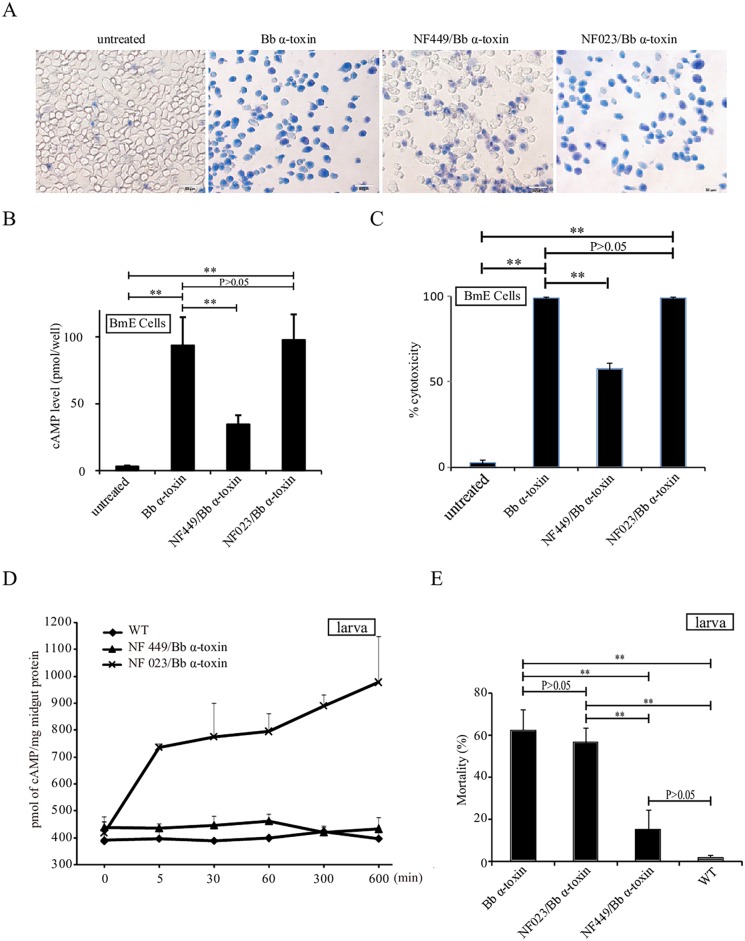
Involvement of Gαs in Bb α-toxin protein pathogenicity.(A) Trypan blue staining of nuclei of BmE cells pre-treated with NF449 (1μM) or NF023 (1μM) with Bb α-toxin-induced cytotoxicity. NF449-treated cells (NF449/Bb α-toxin) were protected from cytotoxic action of Bb α-toxin protein whereas NF023-treated cells (NF023/Bb α-toxin) were not. Blue color represents dead cells; live cells appeared colorless. (B) Effect of the inhibitors NF449 and NF023 at 1μM on cAMP production in cells. cAMP was measured in BmE cells after treatment with Bb α-toxin protein in the presence or absence of the indicated inhibitor. (C) Relative cytotoxicity (%) of Bb α-toxin protein in the presence of NF449 or NF023. (D) Assessment of cAMP levels in the presence of NF023 or NF449 under Bb α-toxin protein treatment in vivo. (E) Effects pathogenicity of Bb α-toxin protein in the presence of NF023 or NF449. Mortality rate is total number of 120 insects divided by number that died 5 days after injection of hibitors on Bb α-toxin protein treatment. Error bars depict SEM. Statistically significant differences from the control samples are indicated; **P<0.01; *P<0.05.